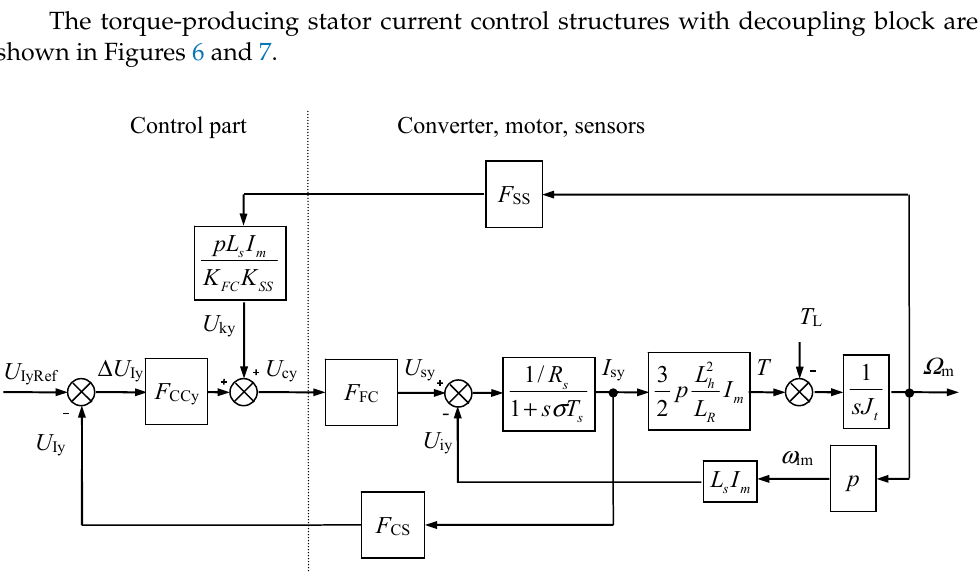
Figure 7. Adjusted torque-producing stator current control structure with decoupling block. From Figures 6 and 7, the transfer function of the open control loop with the decou- pling block is defined by the following equation: (